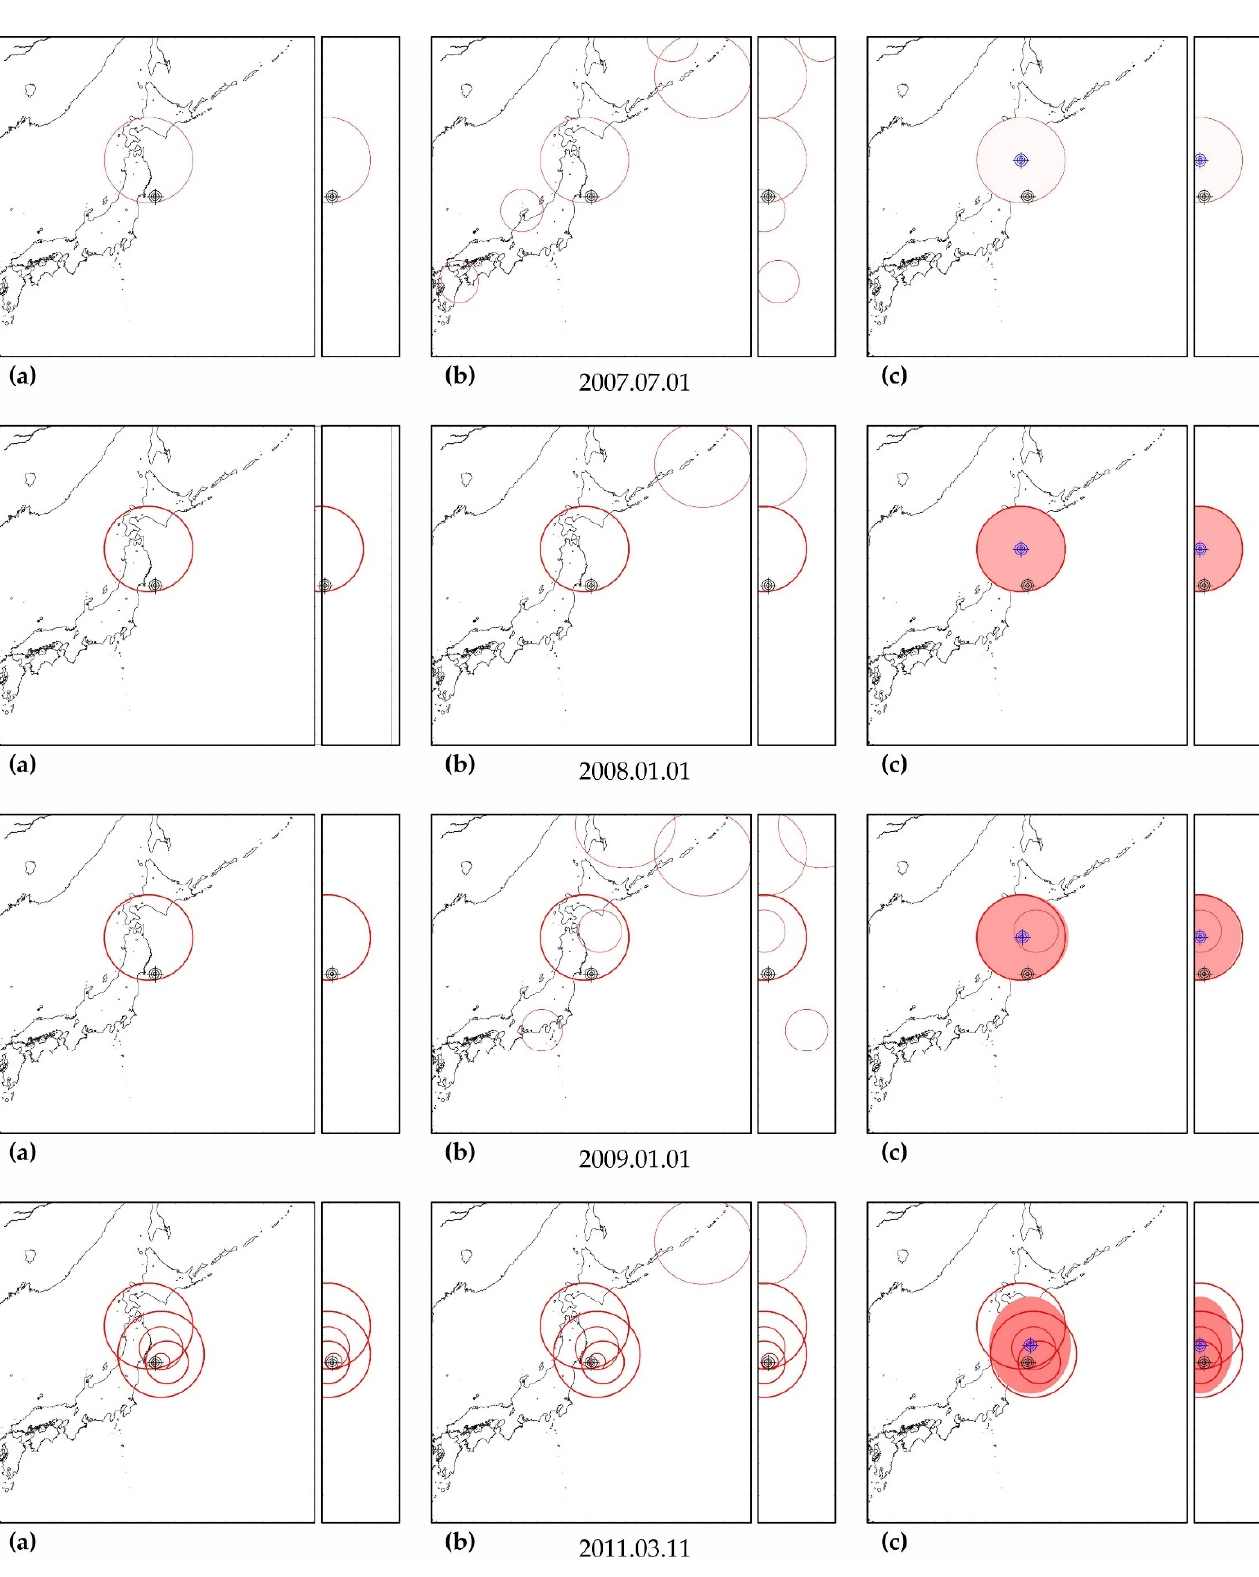
Figure A9. Zones of factual predictability for the earthquake of 11 March 2011 ( a ), identified zones with similar development according to the parameters of the DSDNP equation ( b ) and a cluster of zones of the greatest activity ( c ) used to calculate the time and place of a precedent earthquake (see Figure A3 for explanations).